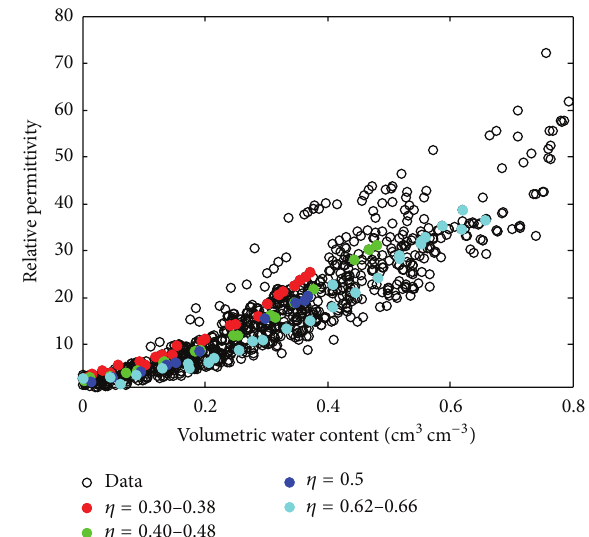
Figure 1: Secondary data of volumetric water content and permit- tivity as a function of porosity.